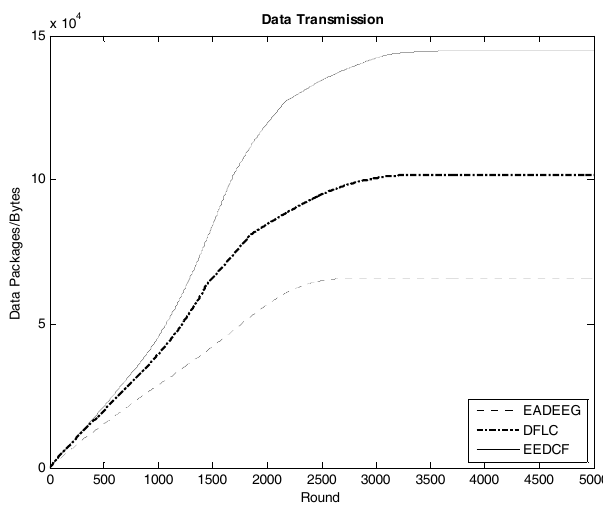
Figure 13. Data transmission in the network of the three algorithms in Scenario 1.